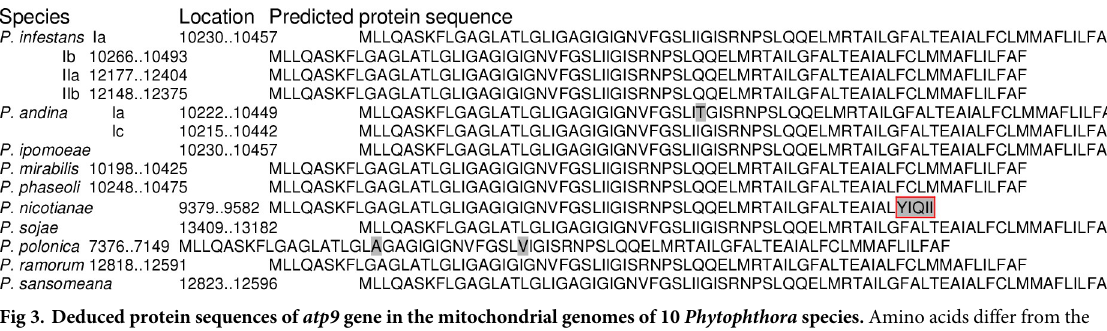
this was caused by a deletion from the 3’ end of atp9 gene that extended into the intergenic region between atp9 gene and nad9 gene. This deletion removed the last 13 amino acids in atp9 protein and replaced it with five non-homologous amino acids (Fig 3).